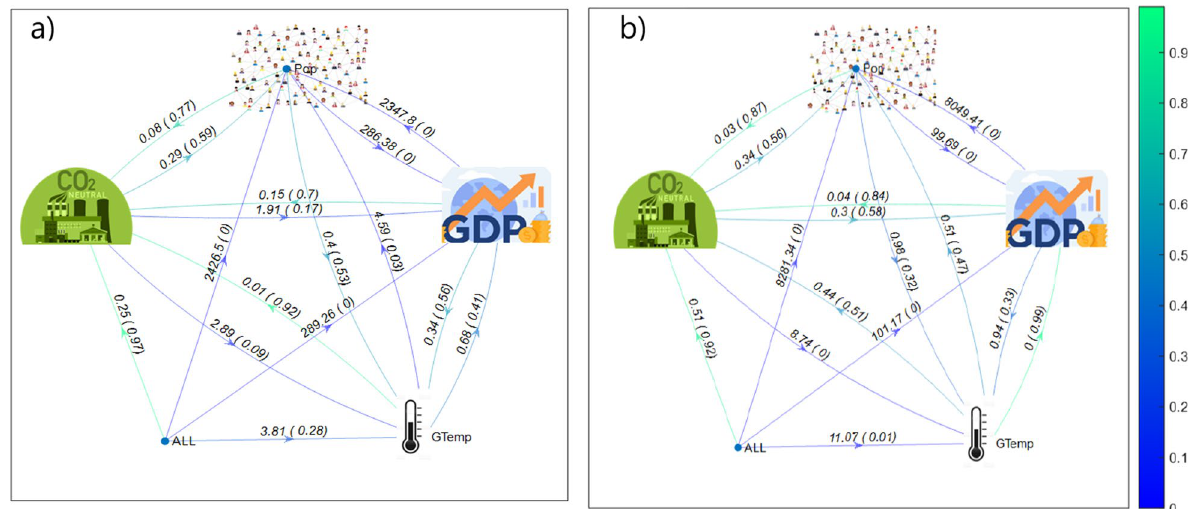
Fig. 7 Causality network after Granger test; edge data representing the Wald X 2 (p) values and edge color corresponding to p ‑values of a 103 years and b 34 years from 1987 to 2020 data. ( All ∈ { variables | connectedvariable / ∈ variables } , colorbar indicates the range of p ‑values of X 2 test, Figures are licensed under CC‑By